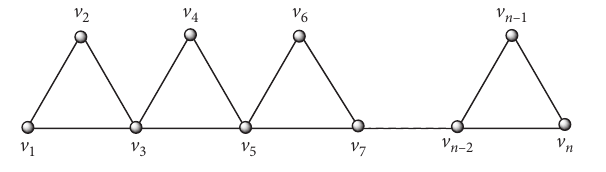
Figure 1: Triangular snake graph TS